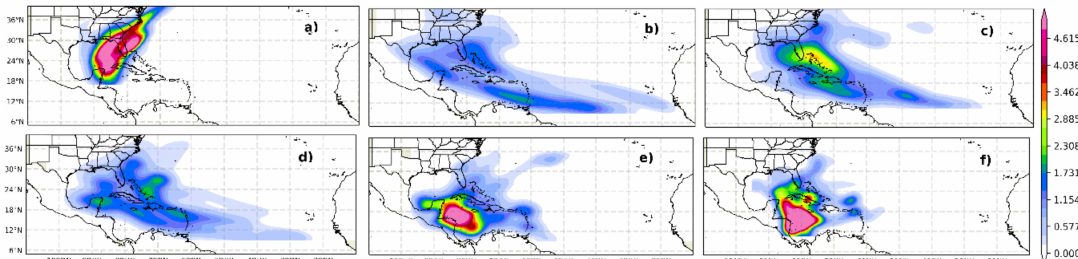
Figure 3. The probability density function (PDF) (10 − 3 ) for single trajectories of TCs that a ff ected Cuba during: ( a ) June, ( b ) July, ( c ) August, ( d ) September, ( e ) October and ( f ) November. Period: